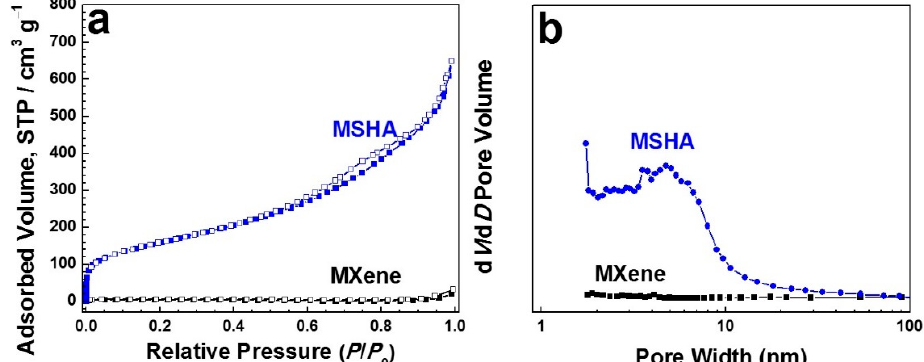
Figure 4. Porous property of the obtained MSHA and MXene: ( a ) N 2 sorption isotherms and ( b ) pore size distributions.